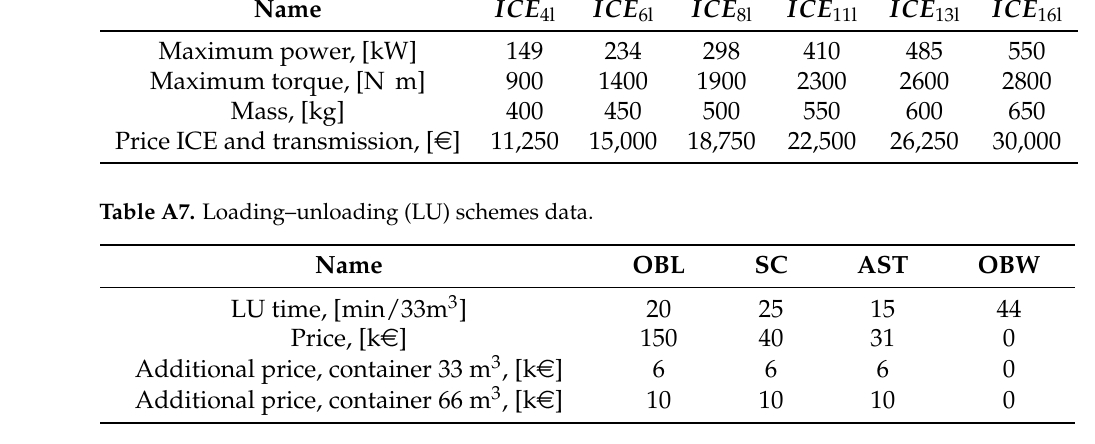
Table A8. Mission and other cost